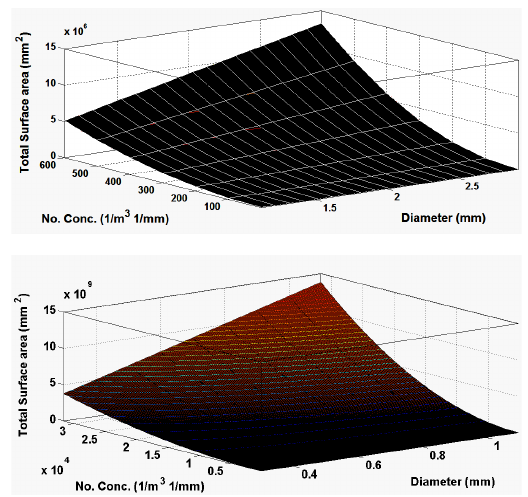
Fig. 5. Total surface area of small and large droplets.